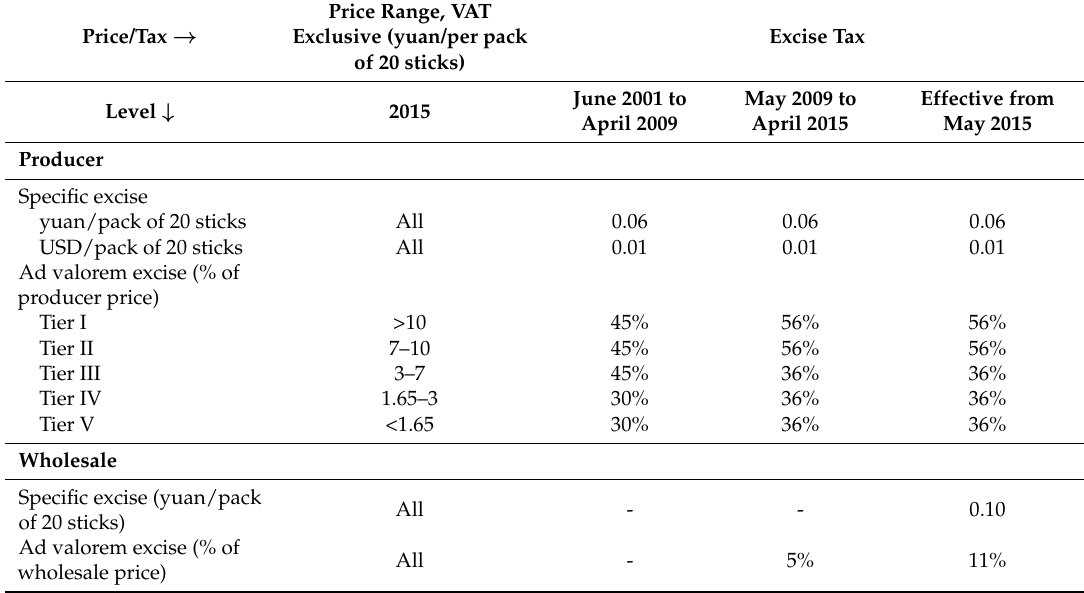
Table 1. Price tiers and excise tax structure of cigarettes in China,